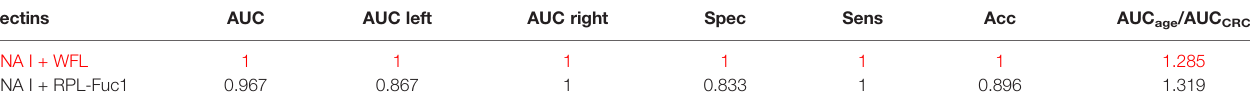
TABLE 2 | Clinical performance characteristics of double lectins for the age matrix with the best combination showed in red.